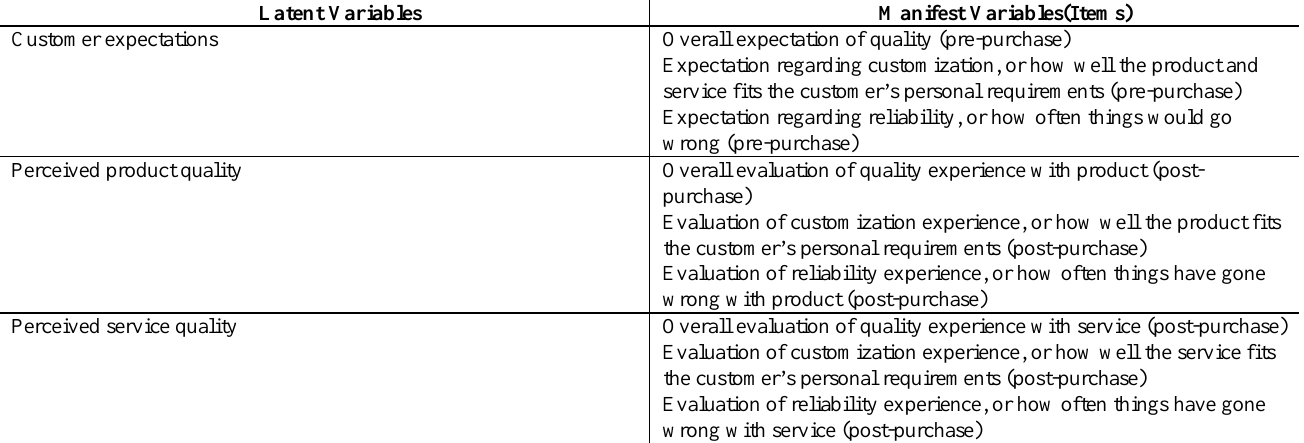
Table 1: Latent and manifest variables of